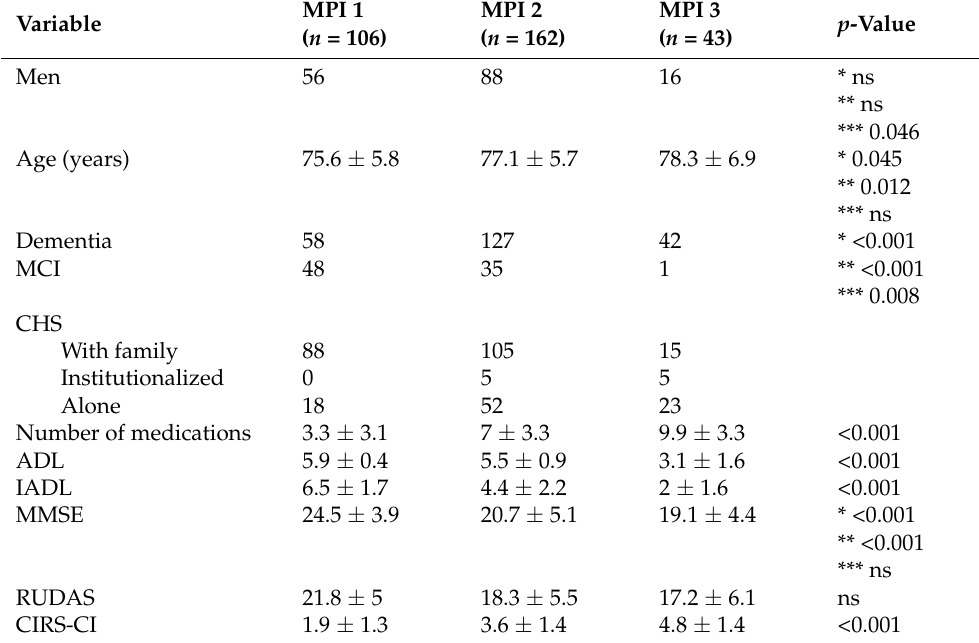
Table 3. General characteristics according to MPI